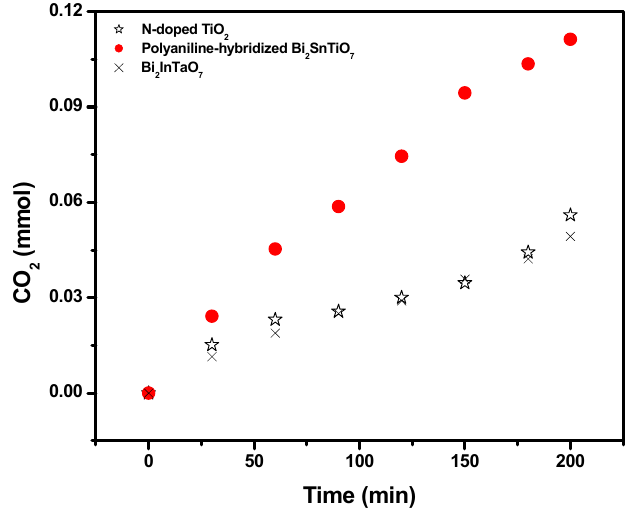
Figure 5. CO with the polyaniline-hybridized Bi visible light